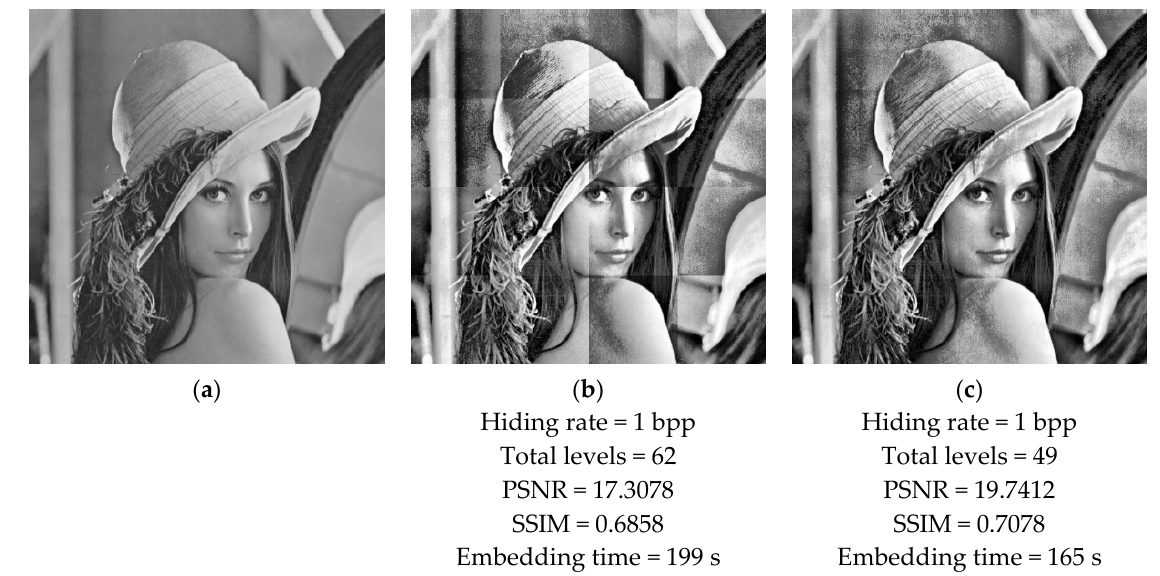
Figure 5. ( a ) Original image, ( b ) enhanced image without block shifting, and ( c ) enhanced image with block shifting.